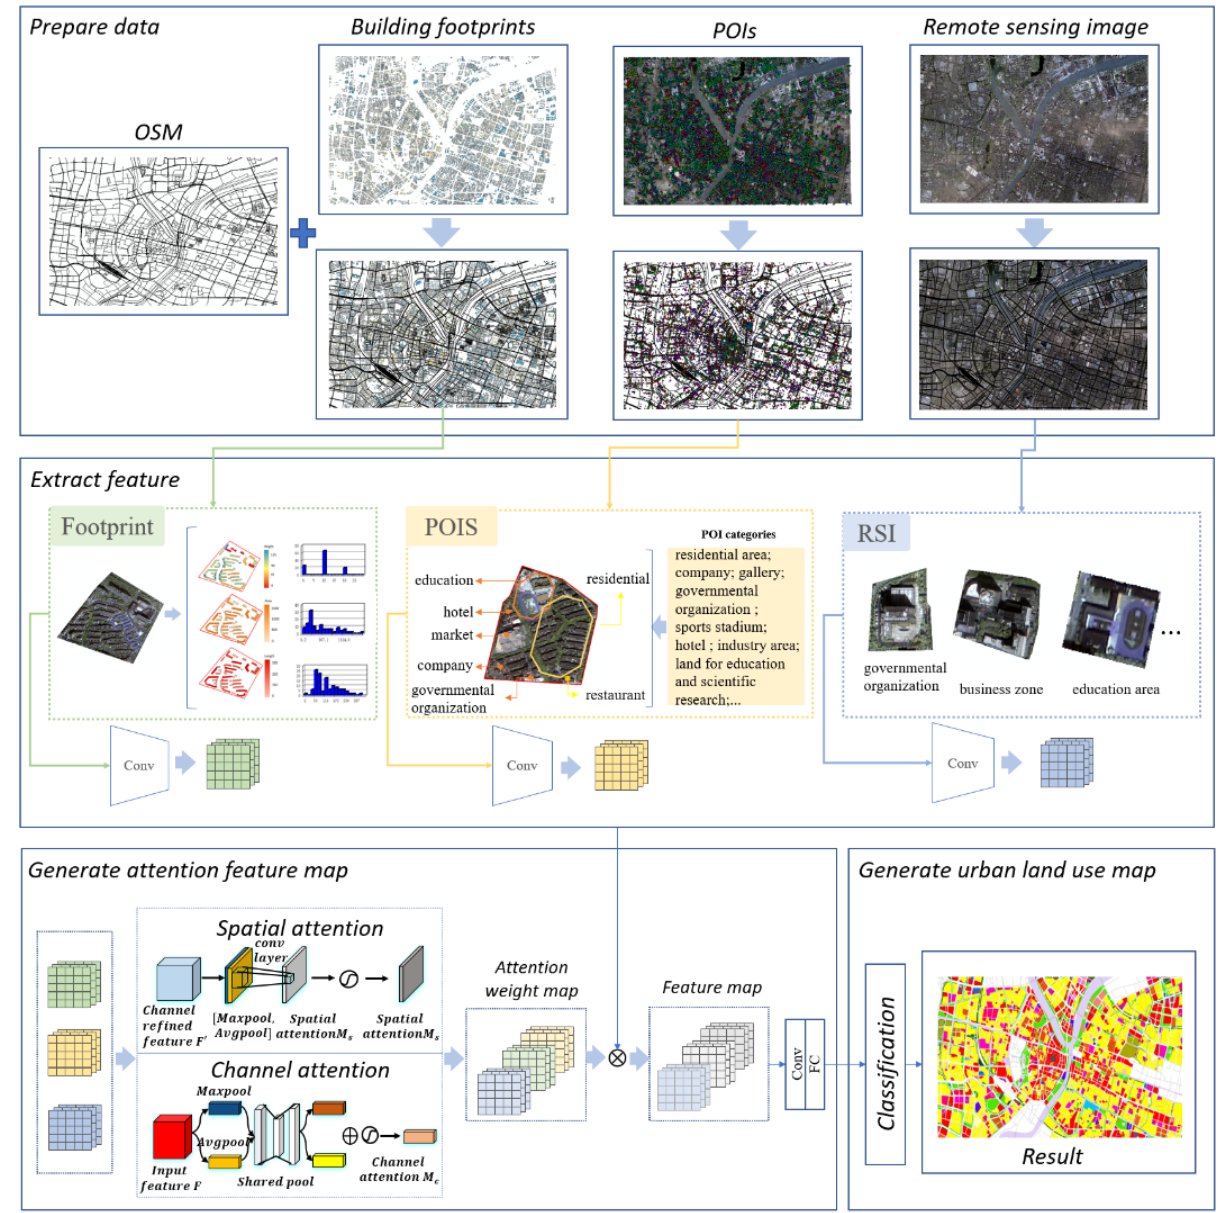
Figure 4. Framework of urban functional area identification.